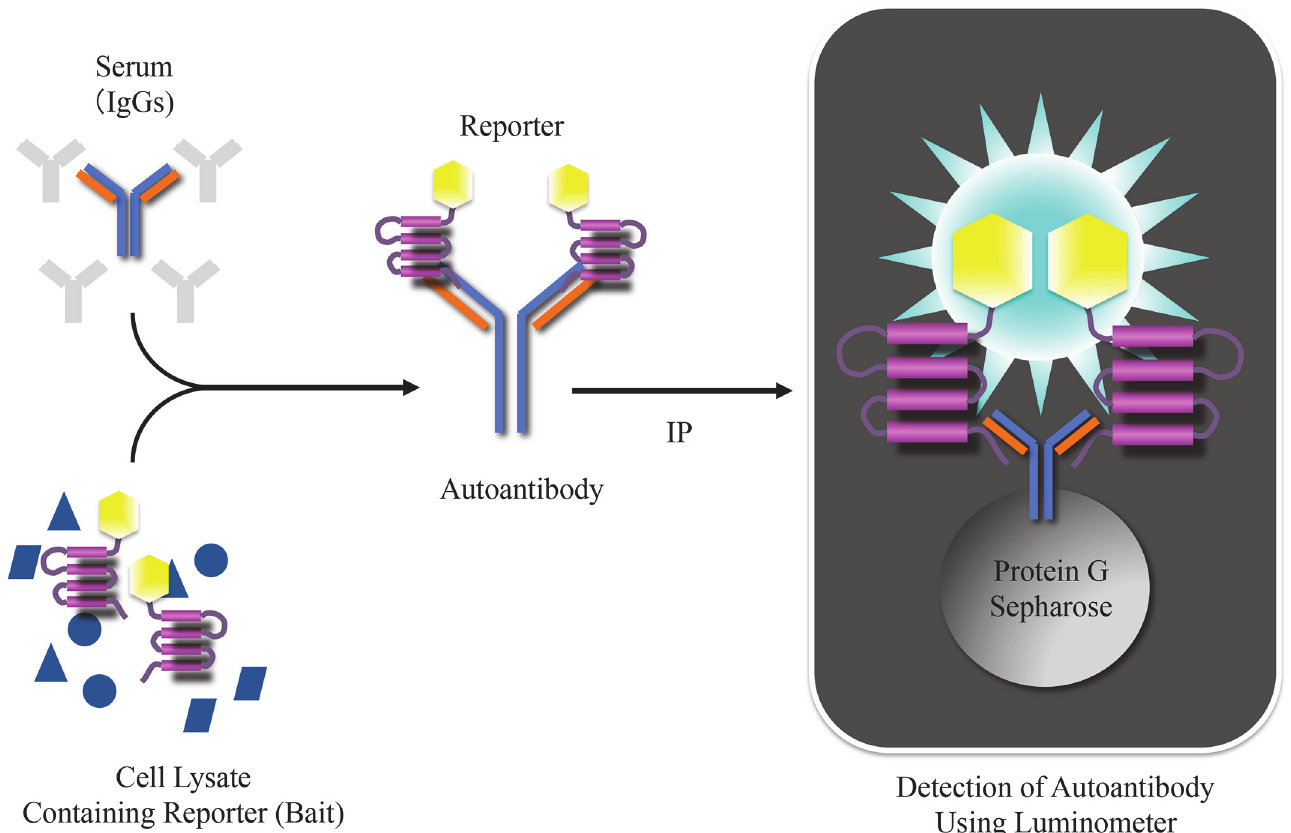
Fig 2. The Luciferase Immunoprecipitation Systems (LIPS). The soluble fractionated component from the solubilized HEK 293F cells, including the gAChR α 3 or β 4-GL, reacted with human serum, and the specific luciferase activities of the gAChR α 3 or β 4-GL were found with the luminometer. The in vitro LIPS assay can quantitatively evaluate an interaction between an antigen and an antibody with high sensitivity and without a